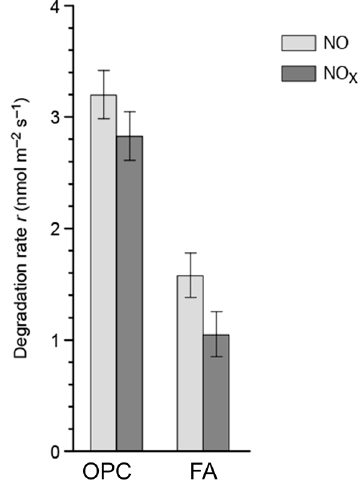
Figure 4. NO and NO x degradation rate r for the ordinary Portland cement photocatalytic sample (OPC) and for the fly ash AAM sample (FA). Measures carried out at 75 ppb NO concentration and 120 ± 5 μ W·cm − 2 UV-A irradiance. Bars are 1 σ repeatability errors.